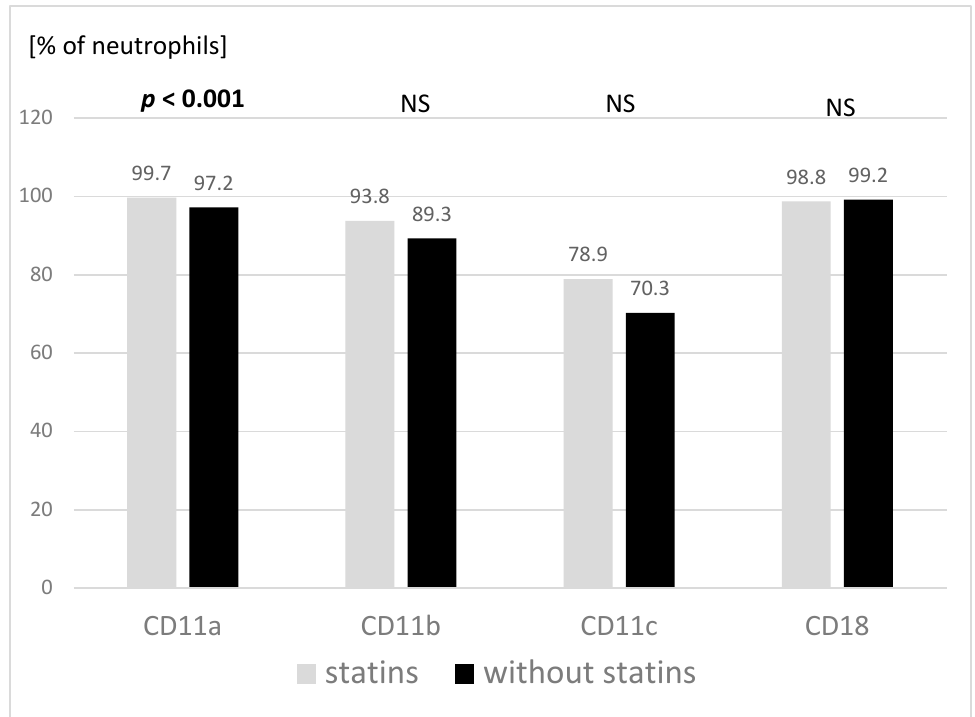
Figure 1. Expression of adhesion molecules on granulocytes in the studied groups with respect to statin treatment (treated with simvastatin n = 11; not treated with simvastatin n = 12). Mann–Whitney two-sided rank U-test was used. NS: not significant.